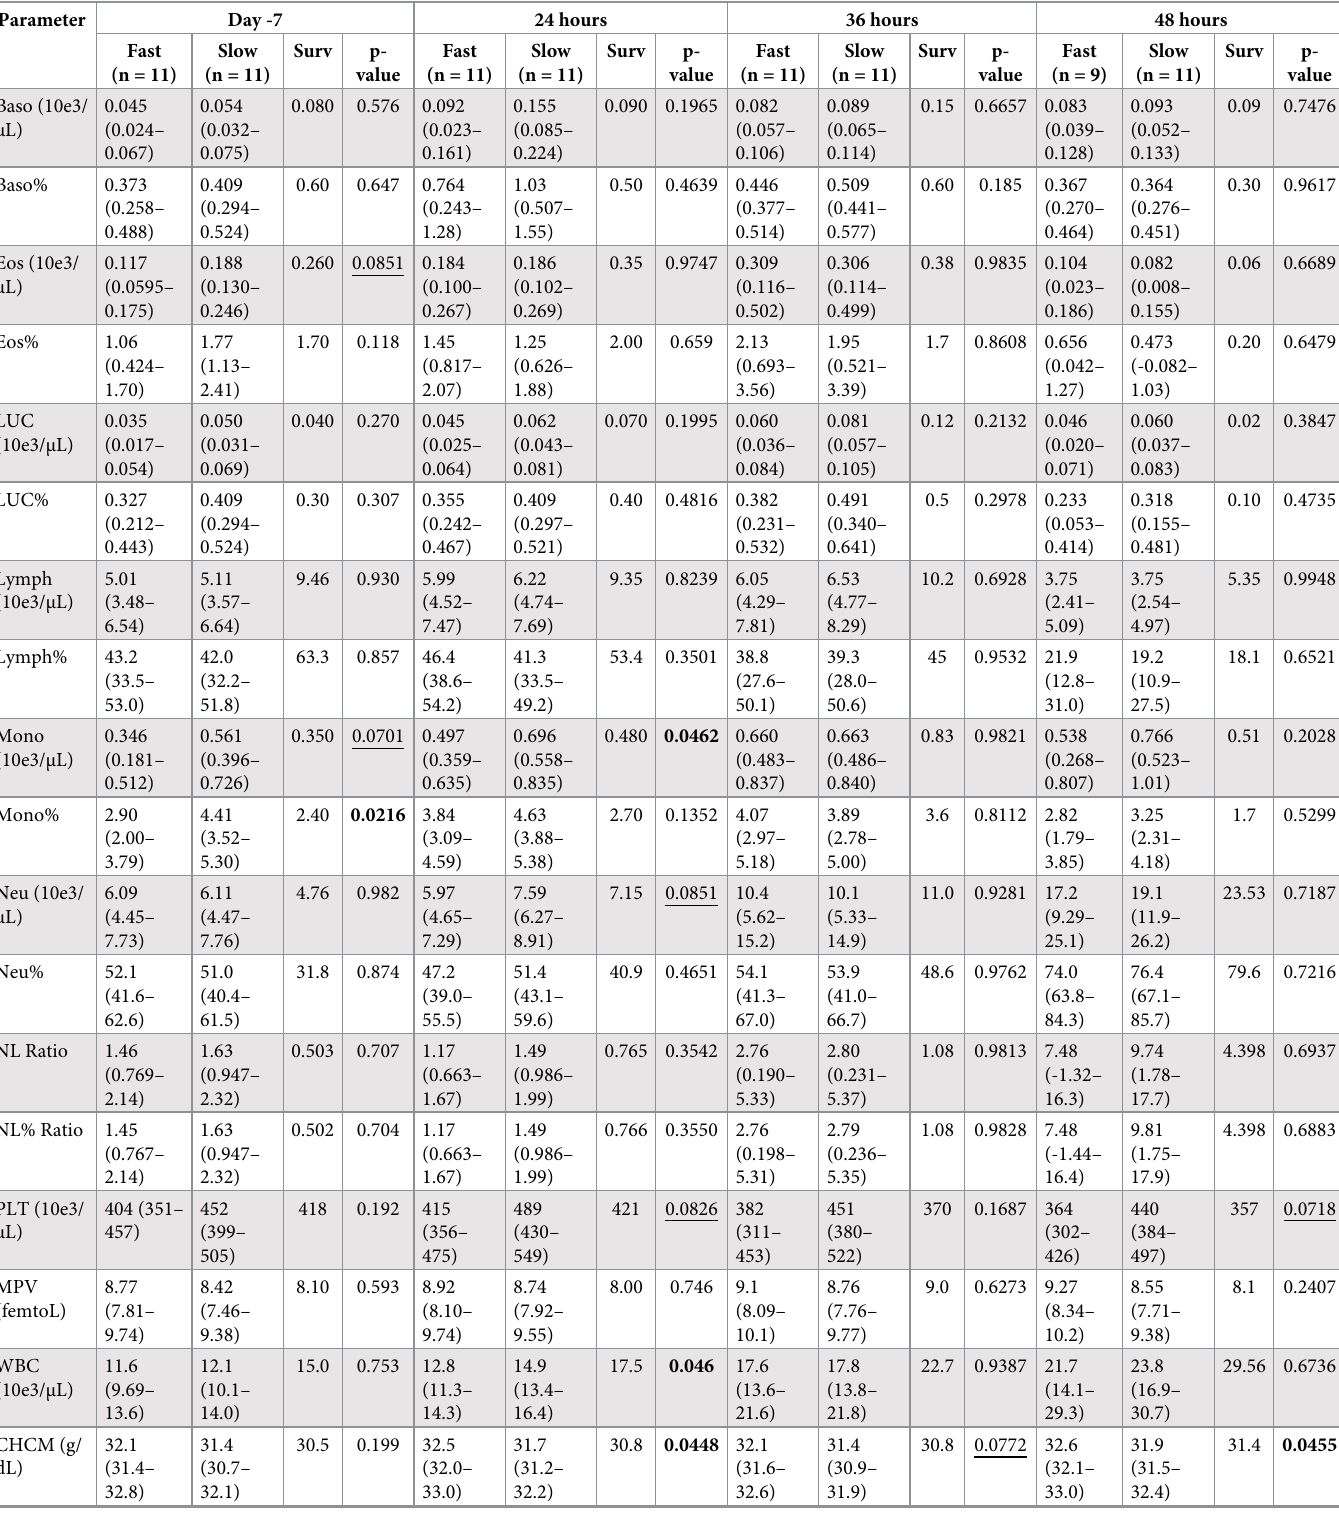
Table 6. Early hematology in cynomolgus macaques with inhalation